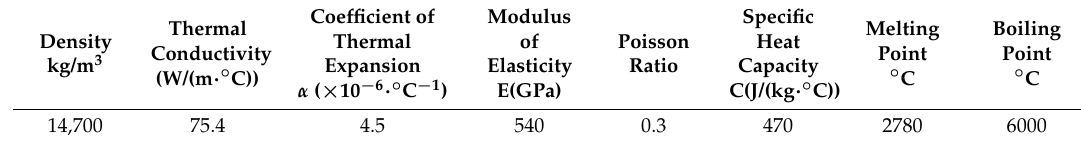
Figure 8. Blade model. Figure 8 . Blade model. Table 6. Material parameters for the Table 6. Material parameters for the tool.